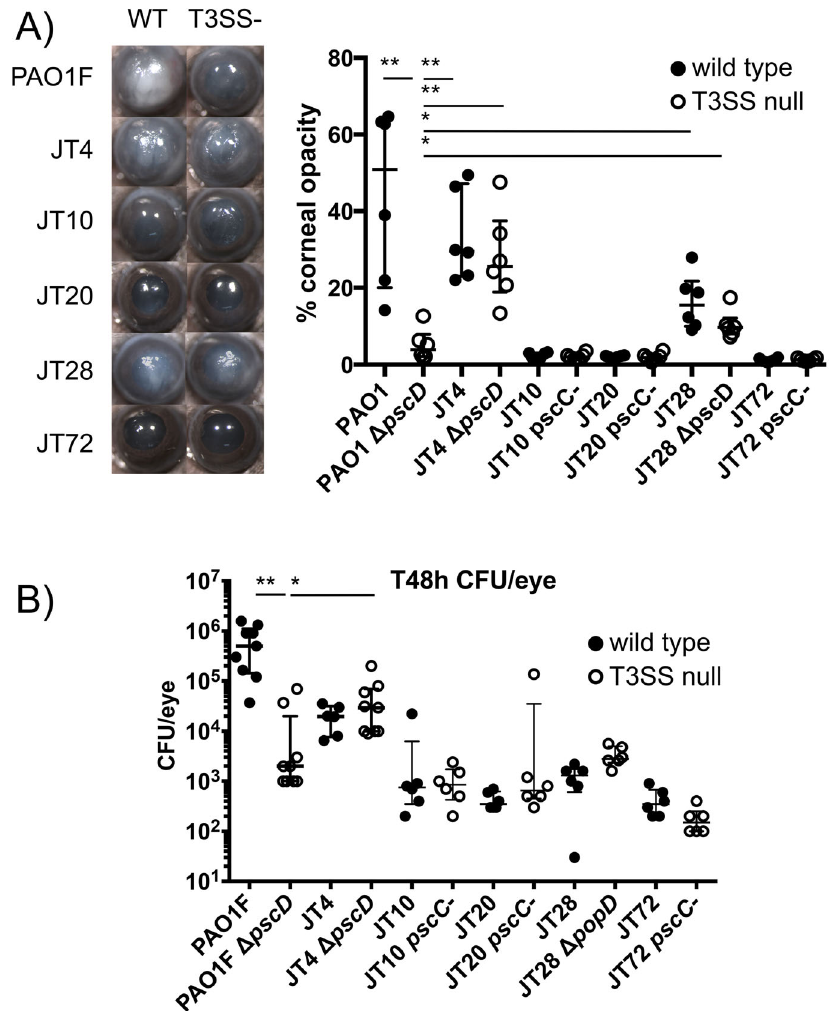
Figure 3. Virulence of effector-negative clinical isolates of P.aeruginosa . Corneas of C57BL/6 mice were scarified and infected with 2*10 ‘ 5 CFU/eye. A) Images of infected eyes were taken at 24 h and 48 h post-infection to assess corneal opacification due to infiltration of neutrophils. Corneal opacification was quantitated digitally using Metamorph software as described previously [11]. Opacity scores for individual eyes were plotted. The median value with interquartile range is indicated. Representative images of infected corneas are shown to the left of the graph. Statistical significance of differences was determined by Mann-Whitney test: ** p , 0.01, * p , 0.05 B) Mice were infected with 2*10 ‘ 5 CFU/eye using the scratch model of corneal infection. Bacterial load (CFU/eye) was determined 48 h after infection by euthanizing the mice, removing the infected eye, homogenizing it and plating serial dilutions on BHI agar plates. Bacterial loads for individual eyes were plotted. The median value with interquartile range is indicated. ** p , 0.01, * p , 0.05, Mann-Whitney